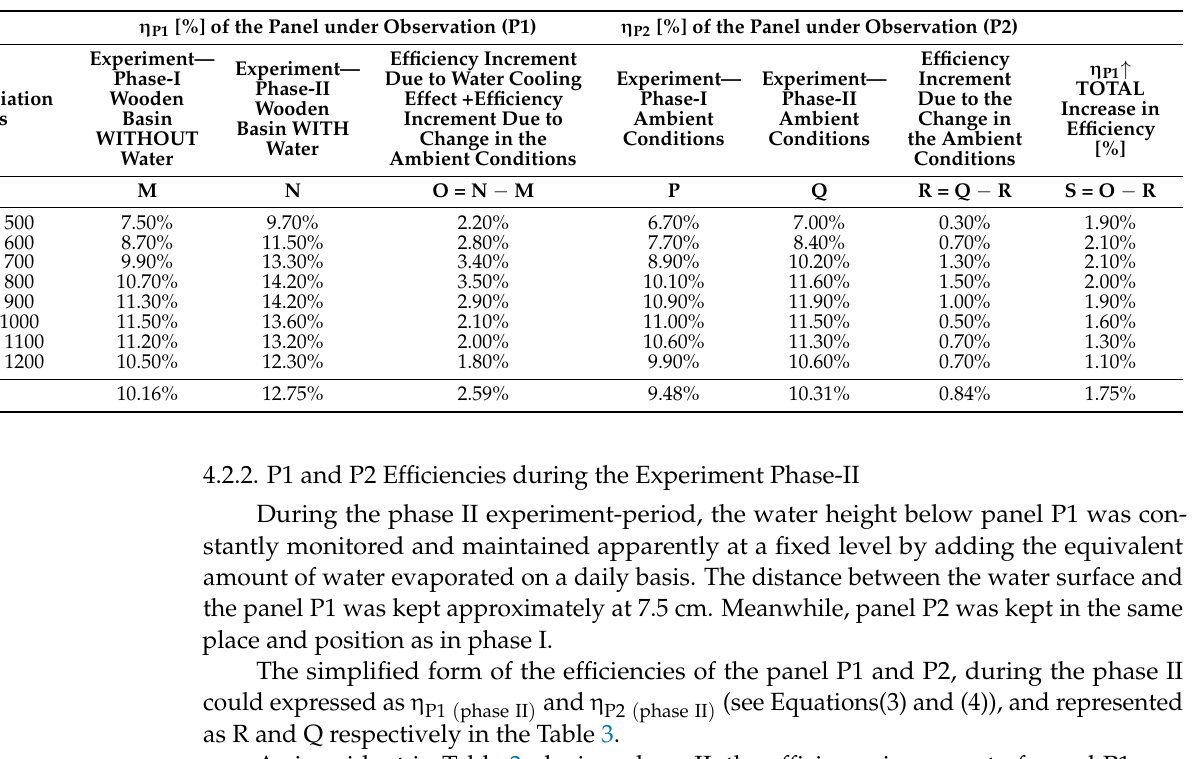
Table 3. P1’s efficiency increment (the panel under